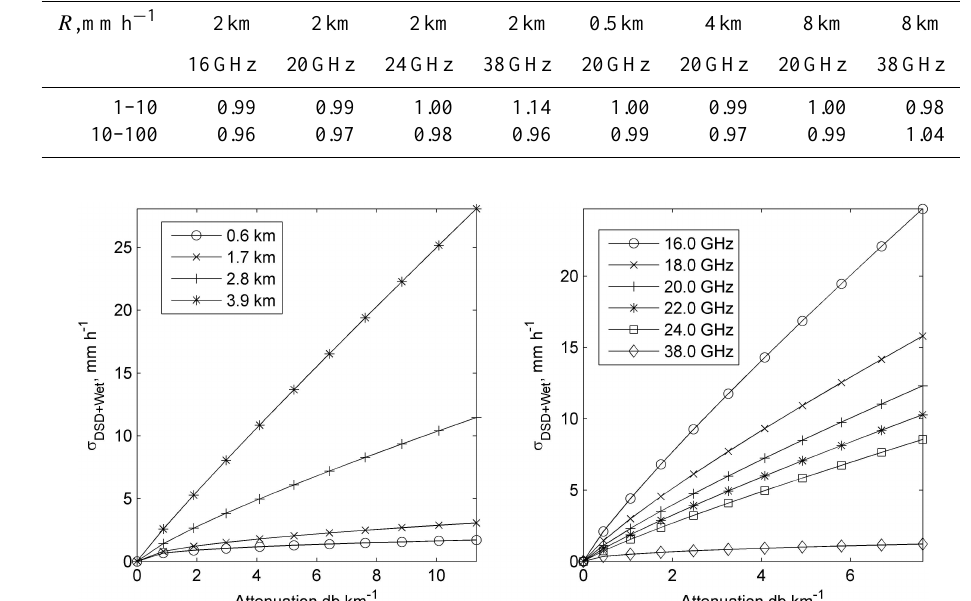
Table 4. The performance statistics S DSD + Wet Eq. (33) for various rain rates and frequencies.